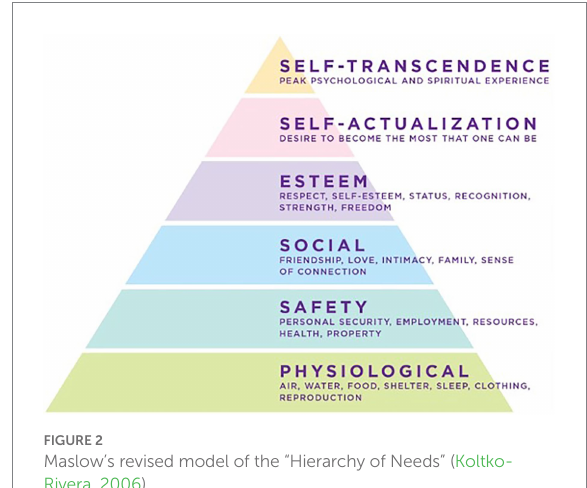
FIGURE 2 Maslow’s revised model of the “Hierarchy of Needs” (Koltko- Rivera,